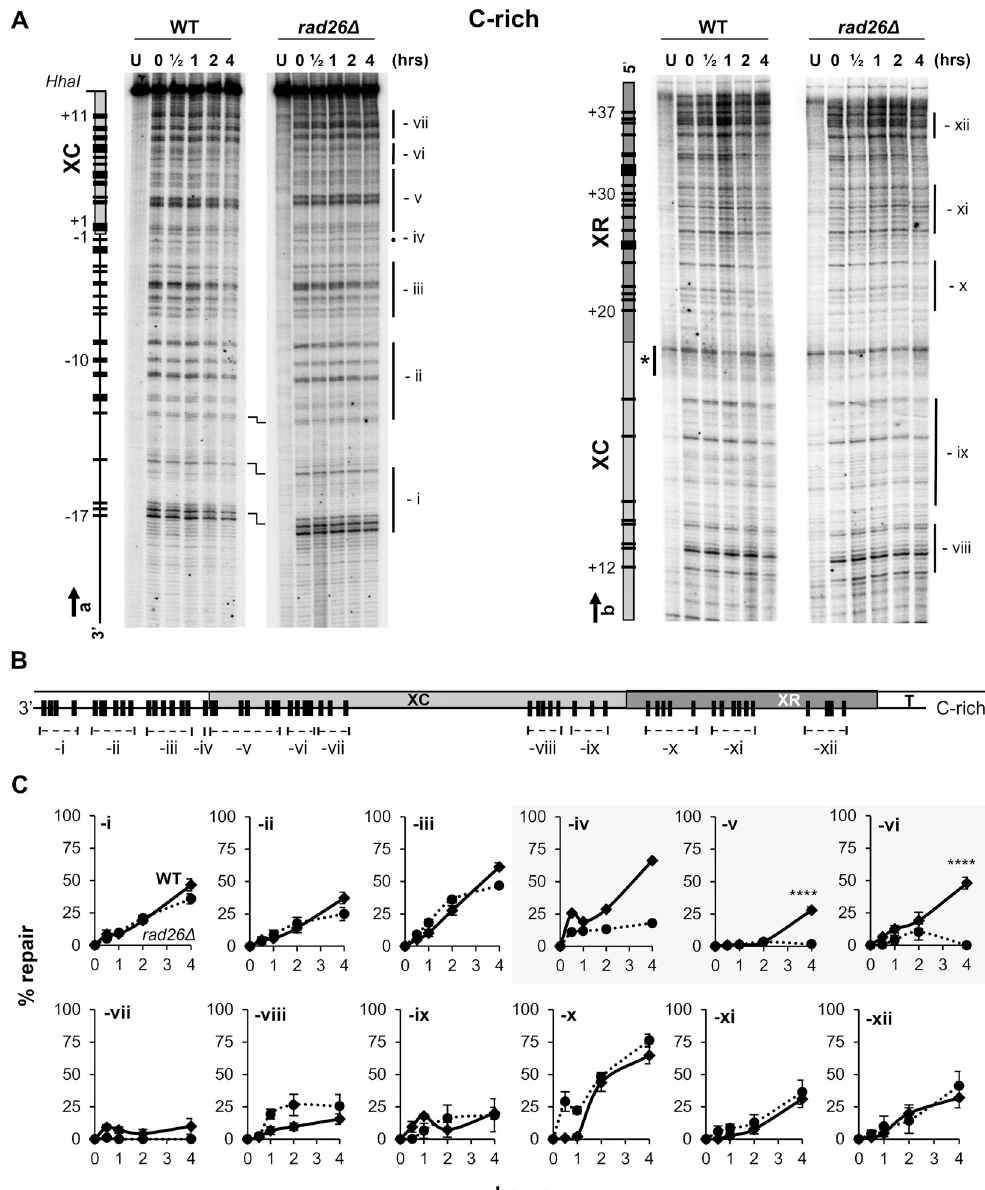
Fig 4. Repair of pyrimidine dimers in the Tel15L X-element of WT and rad26 Δ cells, C-rich strand. Yeast were UV irradiated as described in Fig 3 . Isolated DNA from non-irradiated (U) and irradiated cells (0 to 4 hrs) were digested with Hha I and used as template for TaqI polymerase primer-extension. (A) Repair of PDs was assessed by the extension of primers ‘a’ and ‘b’ (arrows) ( S2 Table ). Description of maps on the left of sequencing gels is as in Fig 3 . PDs that were quantified and plotted in S6 and S7 Figs are represented by black bars and numbered negatively or positively when present outside or inside of the X-element, respectively. The position of PDs was verified by DNA sequencing lanes (not included in the figure). Symbols are as described in Fig 3 , and vertical bars mark PD clusters (‘-i’ to ‘-xii’). (B) General map of the X- element (~730 bp) with the position of PDs (black bars) that approximatively reproduce the migration of bands in the gels. (C) Repair plots (percent of repair over time) are for clusters of PDs (‘-i’ to ‘-xii’); WT (diamond, continuous line) and rad26 Δ (circle, dotted line). The means ± 1SE are for clusters of at least 3 PDs. P -values were calculated using a 2way ANOVA test using a S ˇ ı´da´k’s multiple comparisons test. P -values are indicated for the 4 h repair time point: ( ���� ) p < 0.0001. ANOVA test cannot be applied to cluster–iv that comprises only 1